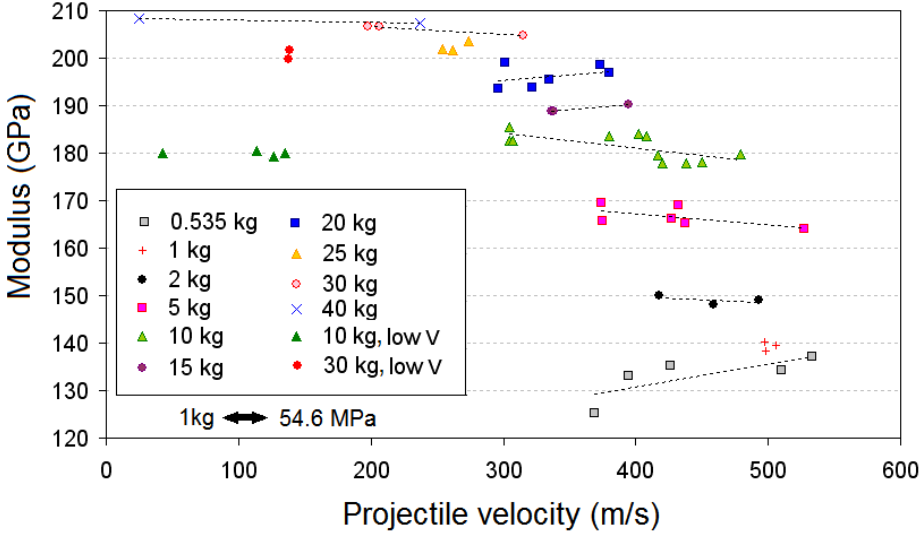
Figure 7. Yarn Young’s modulus calculated from the results shown in Figure 6 as well as additional impact experiments at low velocity.